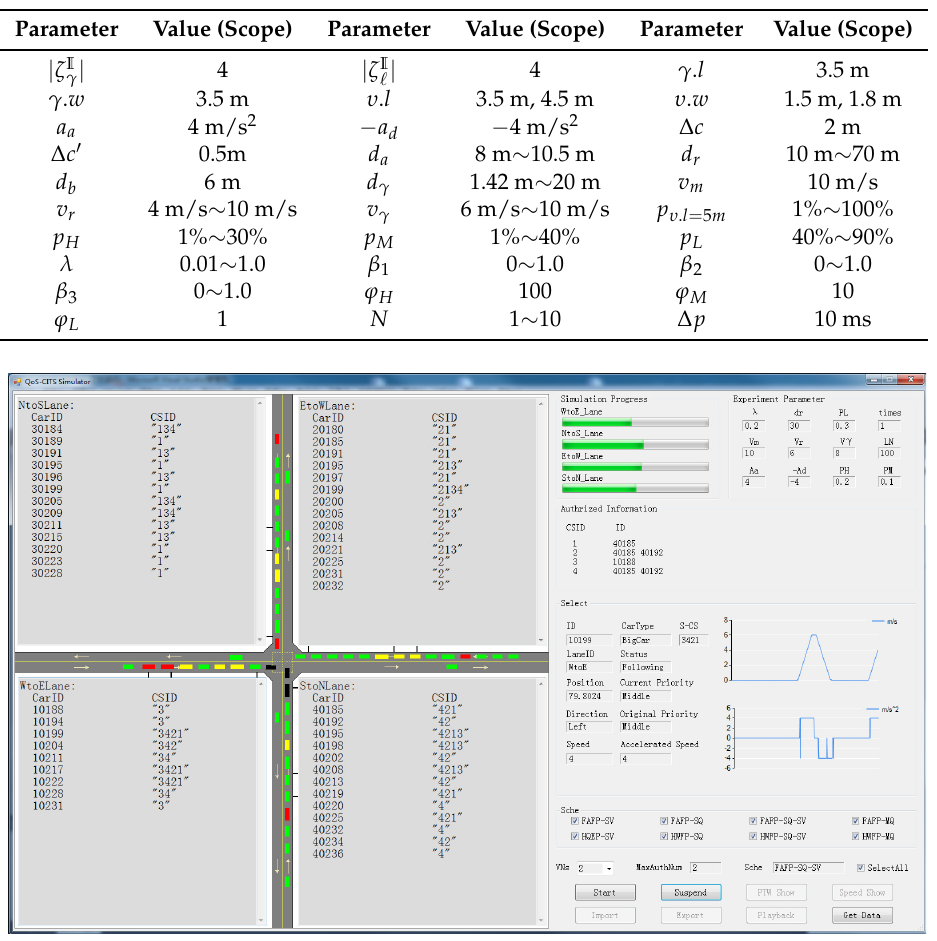
Figure 8. The Traffic Simulator QoS-CITS